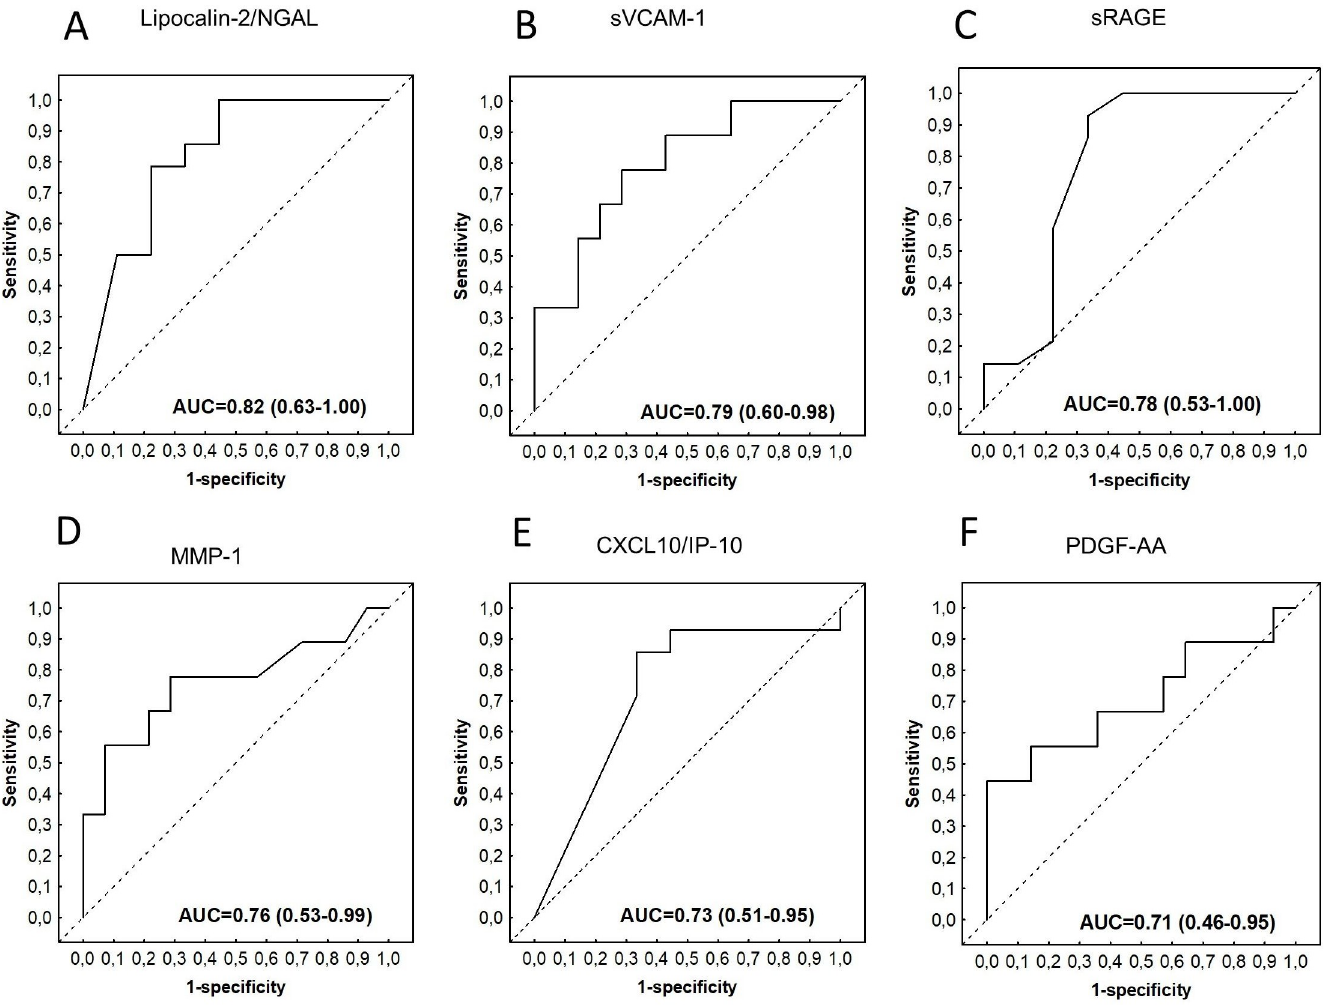
Fig 3. Receiver operator characteristic (ROC) curves showing the accuracies of baseline CSF lipocalin-2/NGAL (A), sVCAM-1 (B), sRAGE (C), MMP-1 (D), CXCL10/ IP-10 (E), and PDGF-AA (F) in indicating stroke among children diagnosed with TBM. ROC curves for analytes with AUC � 0.70 are shown.